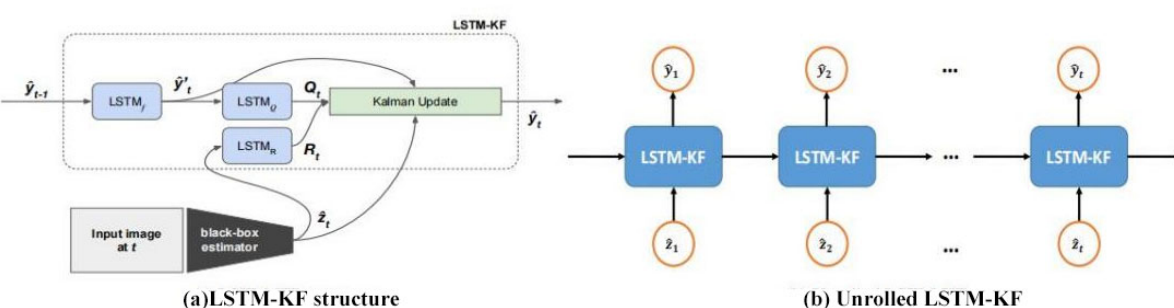
Figure 9. Overview of the LSTM-KF model: ( a ) a high-level depiction of the architecture which uses three LSTM modules to predict the internals of the KF; ( b ) LSTM-KF unrolled over time, which can be trained end to end with backpropagation.